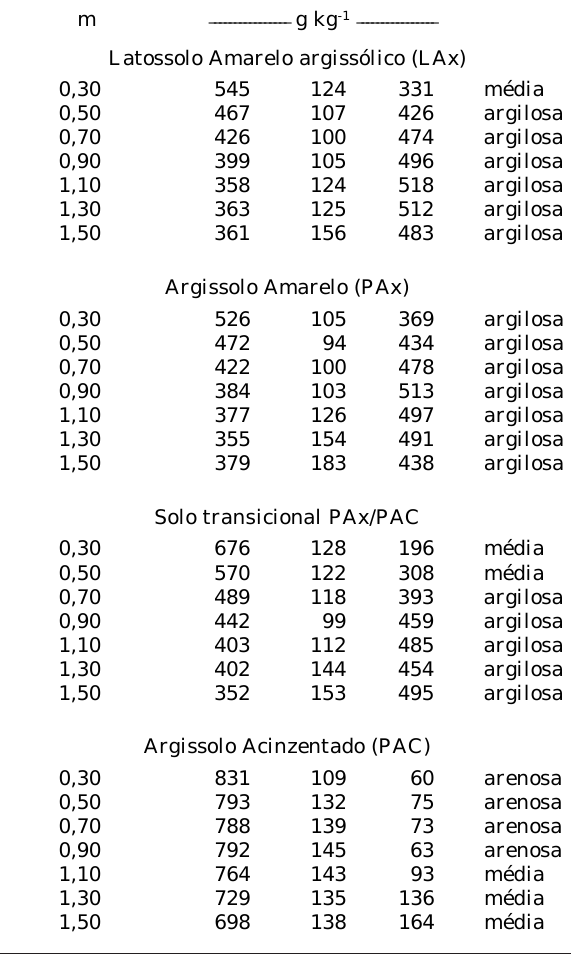
Quadro 4. Resultado da análise de variância dos dados de umidade do solo coletados em uma toposseqüência em tabuleiro, localizada em Sapeaçu (BA)